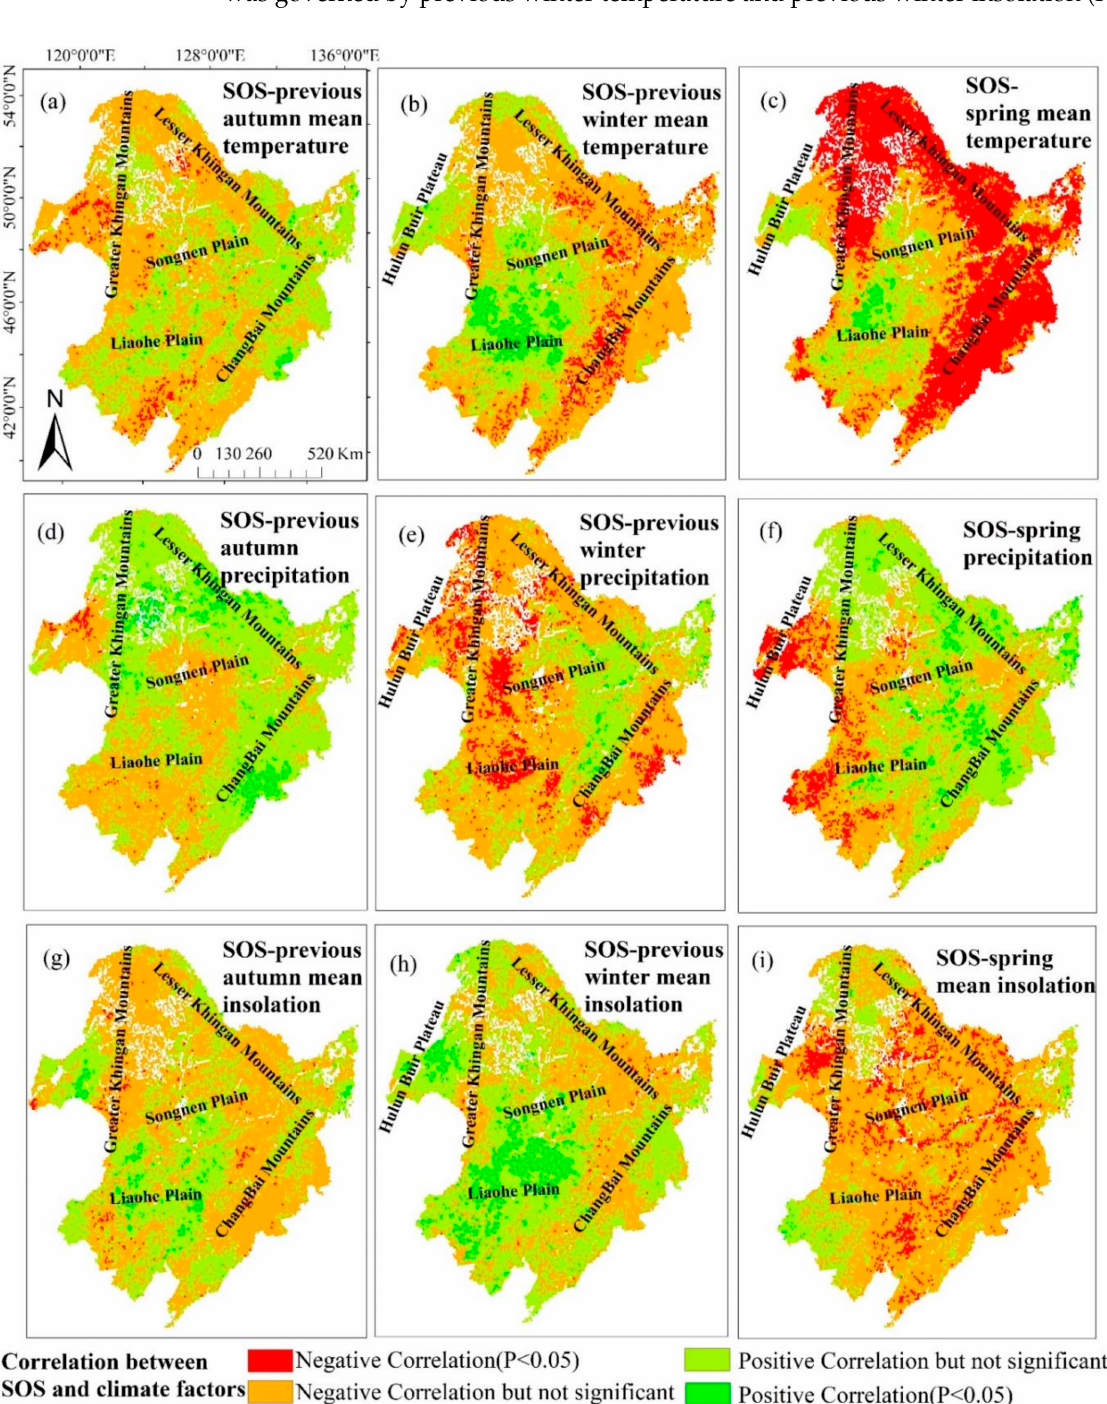
Figure 6. Correlation of SOS with climate variables of northeast China during 1982–2014. ( a , b , c ) present correlations of SOS with previous autumn mean temperature, previous winter mean temper- ature, and spring mean temperature, respectively. ( d , e , f ) present correlations of SOS with previous autumn total precipitation, previous winter total precipitation, and spring total precipitation, respec- tively. ( g , h , i ) present correlations of SOS with previous autumn mean insolation, previous winter mean insolation, and spring mean insolation,